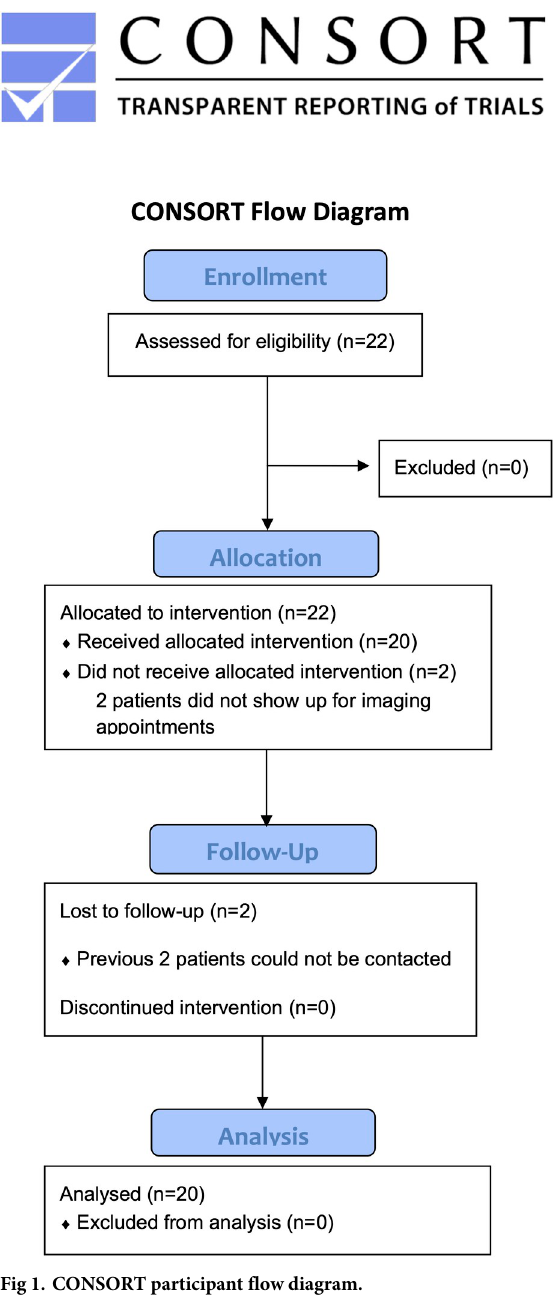
Fig 1. CONSORT participant flow